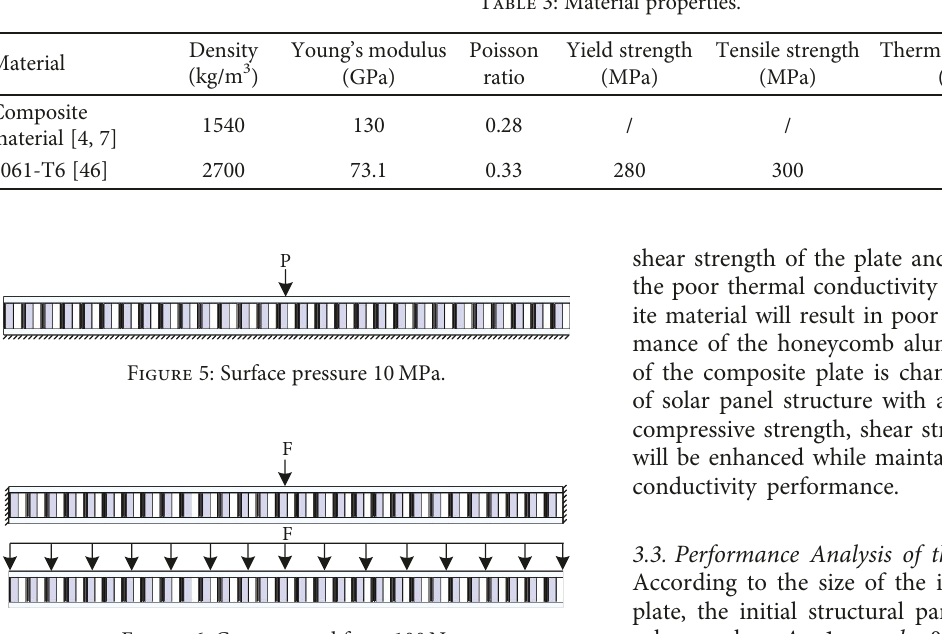
Figure 6: Concentrated force